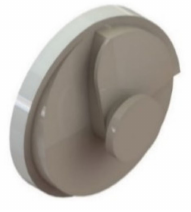
Figure 9. Three-dimensional (3D) computer-aided design (CAD) model of the proposed